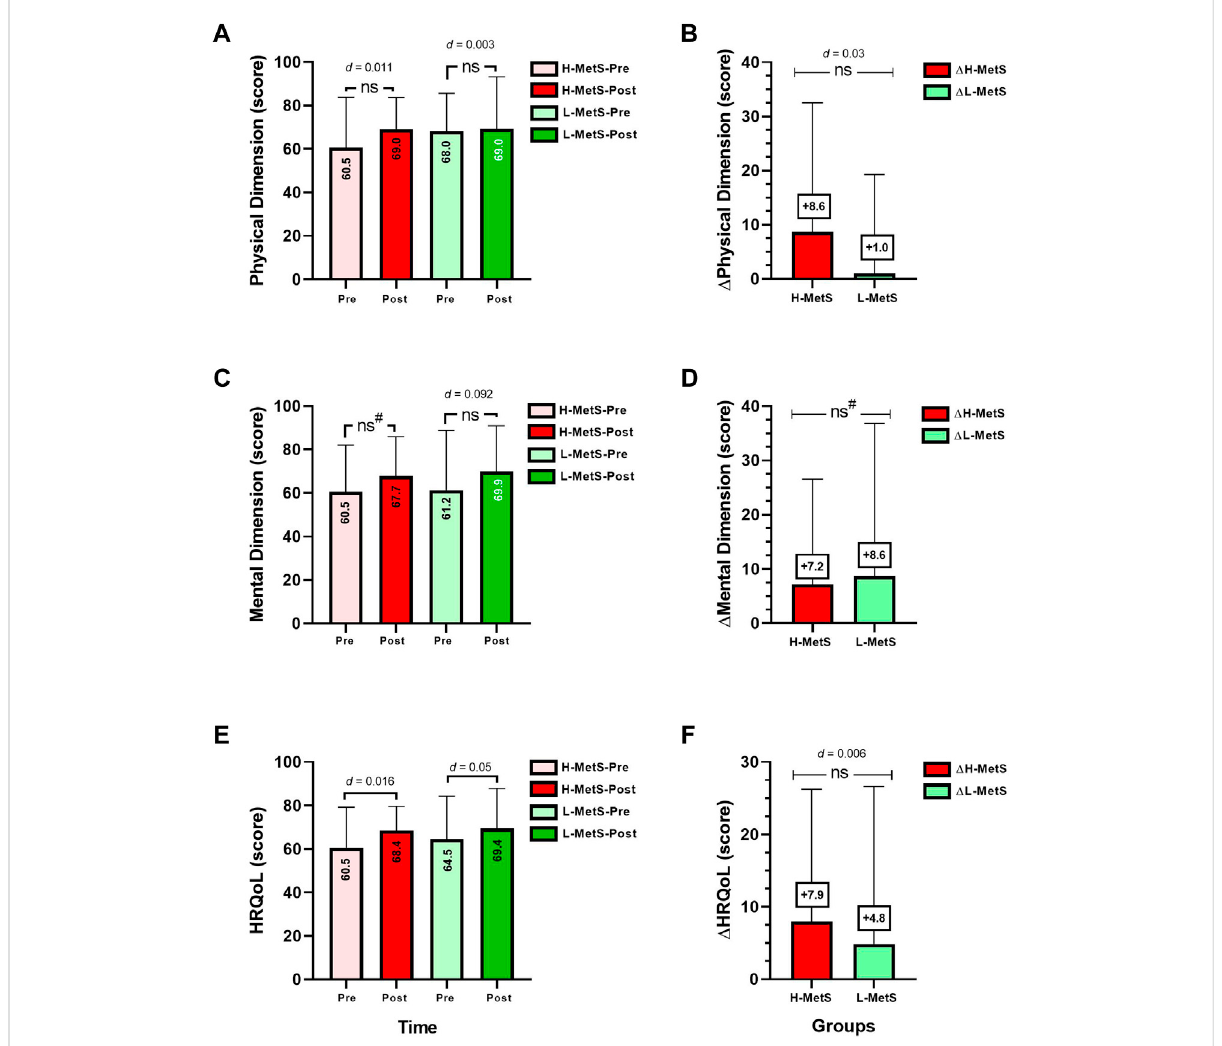
FIGURE 4 Qualityoflifedimensionsbeforeandafter (A,C,E) ,anddeltachanges (B,D,F) betweentwogroupsofadifferentloadofriskfactorsformetabolic syndrome. Groups aredescribed as H-MetS-Pre,highmetabolicsyndrome risk factor group atpre test; H-MetS-Post,highmetabolicsyndrome risk factorgroupposttest;L-MetS-Pre,low-metabolicsyndromeriskfactorgroupatpretest;L-MetS-Post,low-metabolicsyndromeriskfactorgroupat post test; HRQoL, health-related quality of life scores from the SF-36 instrument. ( d ) Denotes Cohen d effect size at p < 0.05. (ns) Denotes no signi fi cant differences between groups. ( # ) Denotes the comparison analyzed by the Mann – Whitney non-parametric